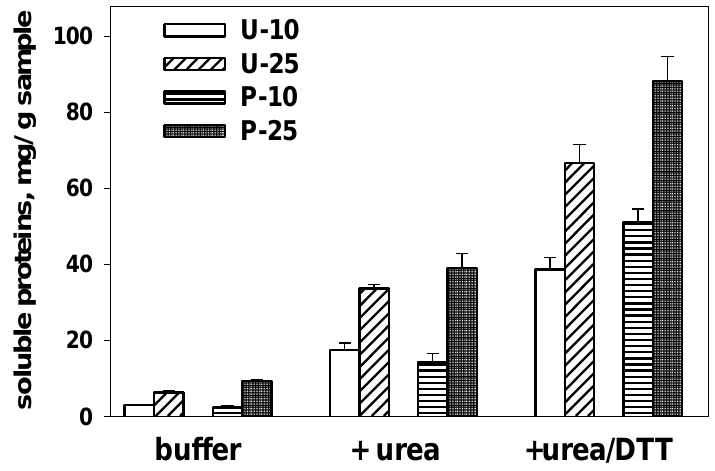
Figure 1. The amount of proteins solubilized from the various samples in different buffer systems. Aliquots of the various samples were suspended under stirring in 0.05 M sodium phosphate, 0.1 M NaCl, pH 7.0, in the presence/absence of 6 M urea and 10 mM DTT, as indicated. Different letters for results obtained with each buffer system indicate significant differences ( p ≤ 0.05). Samples are identified by letters (indicating the use of untreated (U) or parboiled (P) rice) and digits (10, 25) indicating the percent content in soybean flour.